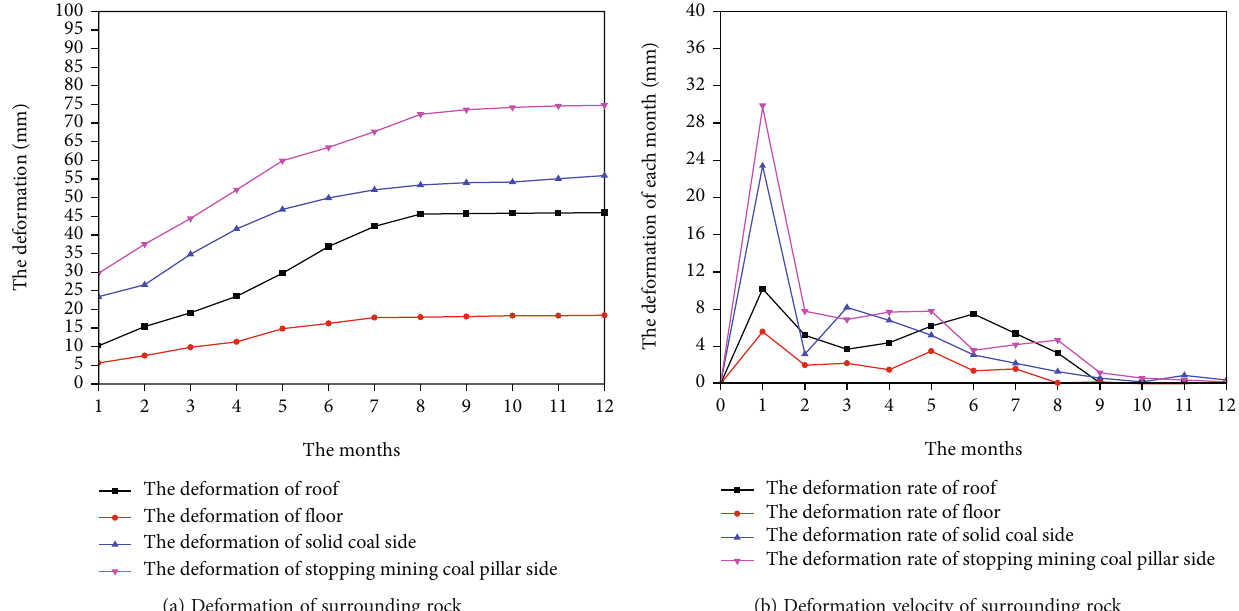
Figure 19: The surrounding rock deformation and deformation speed of the auxiliary main haulage